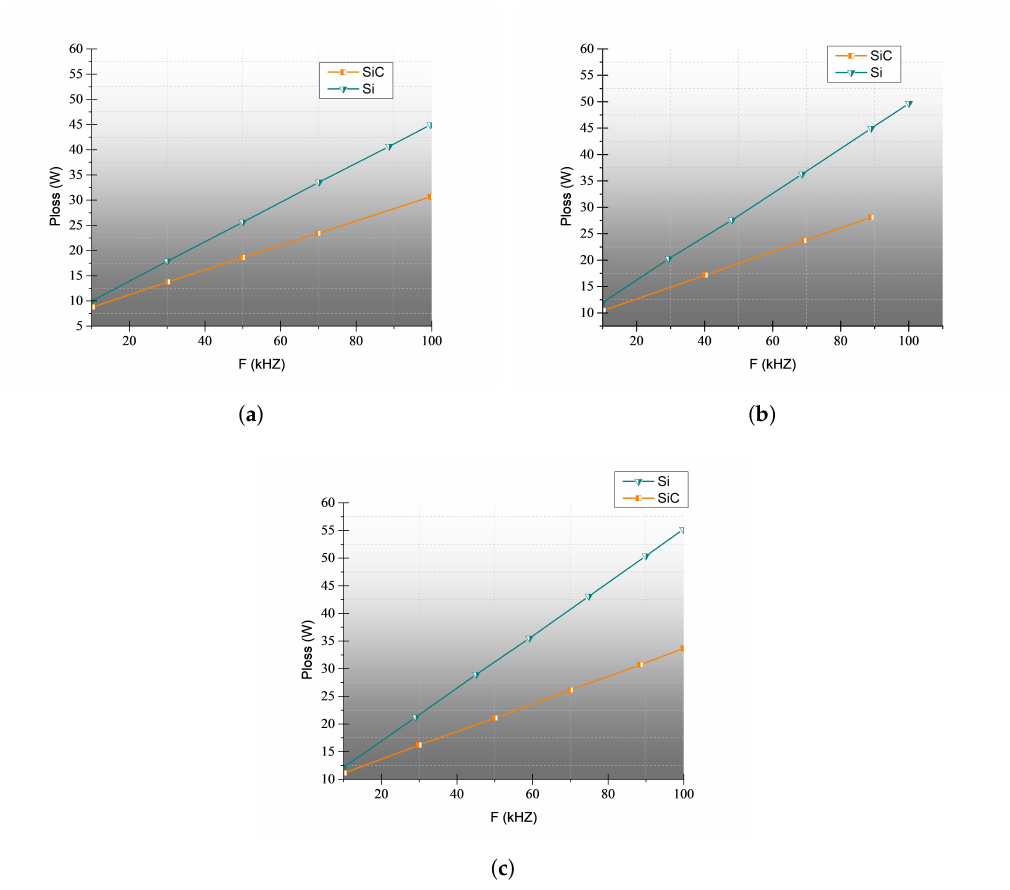
Figure 19. SiC and Si losses at ( a ) T = 25 ◦ C, ( b ) T = 100 ◦ C and ( c ) T= 150 ◦ C.